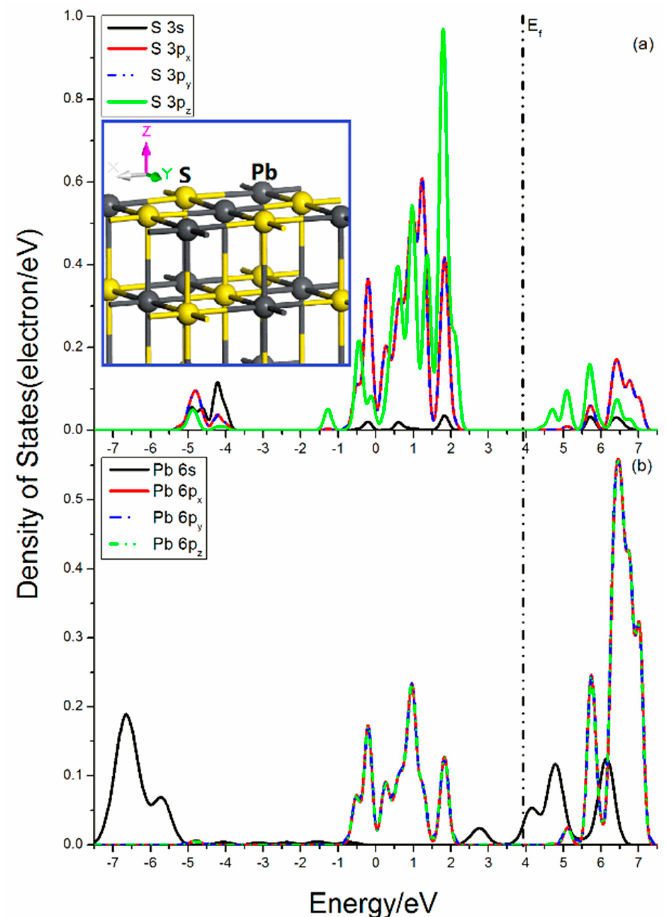
Figure 4. Projected DOSs of S and Pb of galena (100) surface: ( a ) S 3s, 3p x , 3p y and 3p z states; ( b ) Pb 6s, 6p x , 6p y and 6p z states.